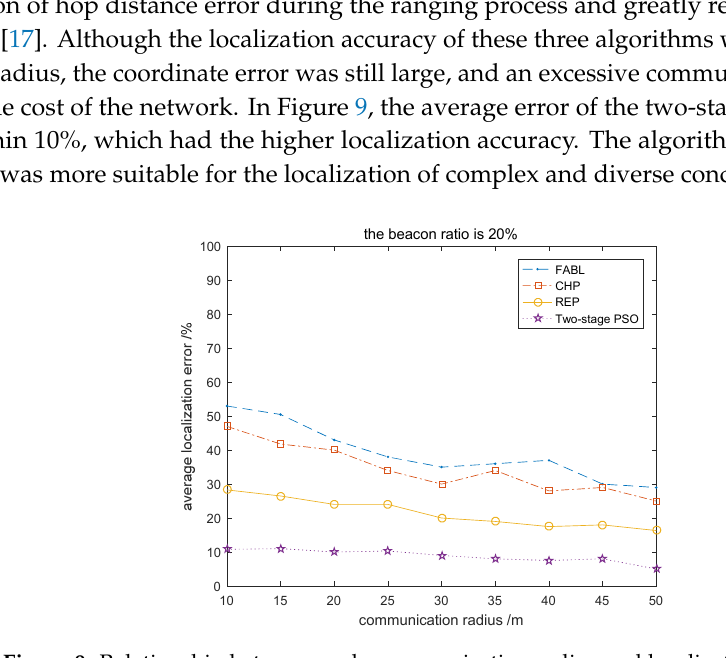
Figure 9. Relationship between node communication radius and localization results.